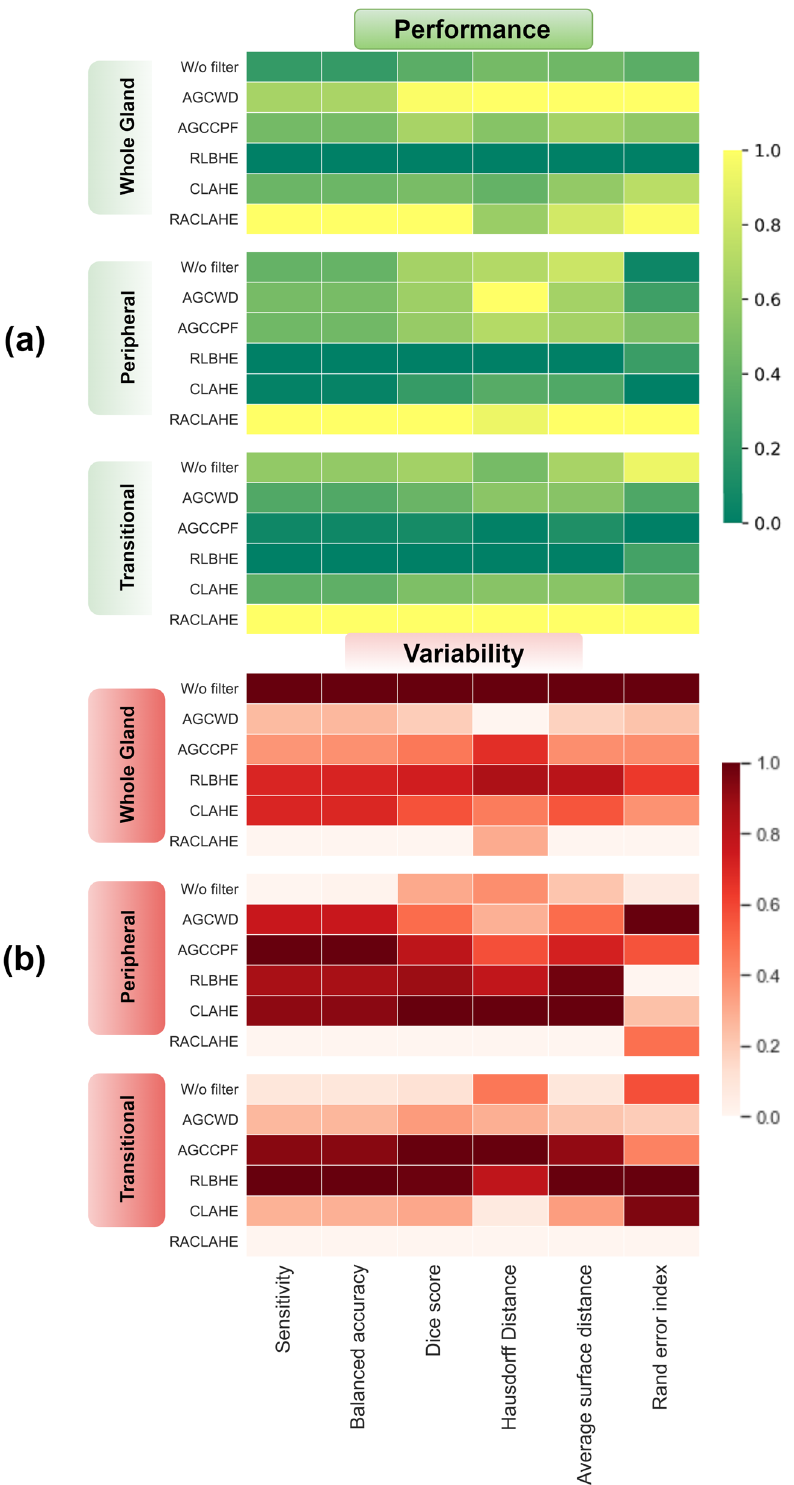
Figure 1. ( a ) Intermodel performance for each metric and histogram based preprocessing technique. The best preprocessing method for each metric is depicted in yellow and the inferior in dark greens. ( b ) Intermodel variability for each metric and the histogram based preprocessing technique. The best method for each metric is depicted in white and the inferior in dark